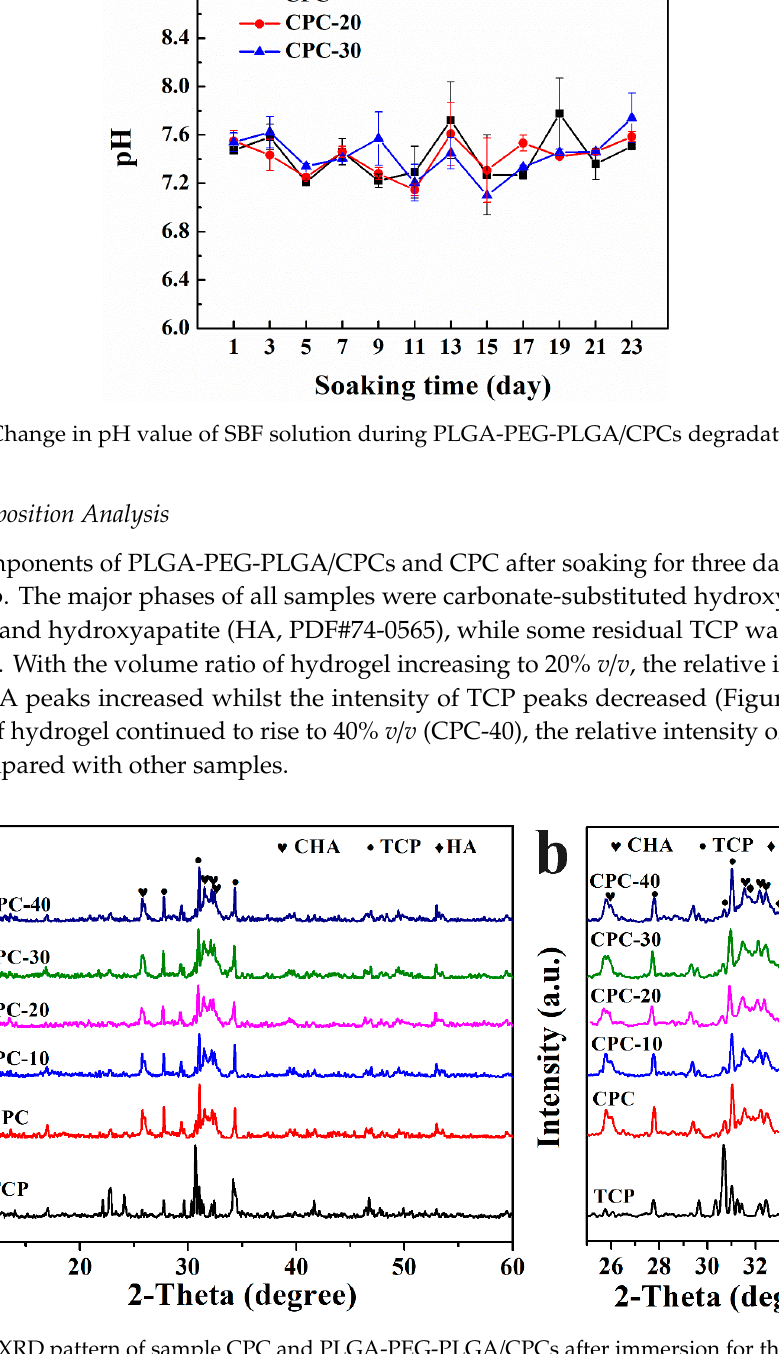
Figure 11. FTIR spectra of sample CPC and CPC-20 after immersion for one day and three days. 3.10. XPS Spectra For better understanding the chemical state of the elements in sample CPC and CPC-20, XPS analysis was conducted. As shown in Figure 12a, the major constituents of CPC and CPC-20 soaked for three days were oxygen, calcium, carbon and phosphorus. The high-resolution XPS spectra of C1s, O 1s, Ca 2p and P 2p are shown in Figure 12b–e. The C 1s spectrum of CPC could be deconvoluted into three peaks at 284.8 eV, 286.4 eV and 288.3 eV corresponding to the C–H/C–C, C–